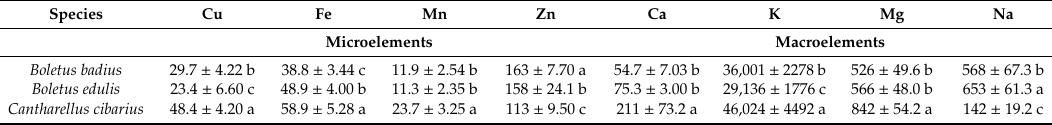
Table 1. Mean content of minerals in the studied mushrooms ( x ± SD), ( n = 60) [mg / kg d.w.]. Species Cu Fe Mn Zn Ca K Mg